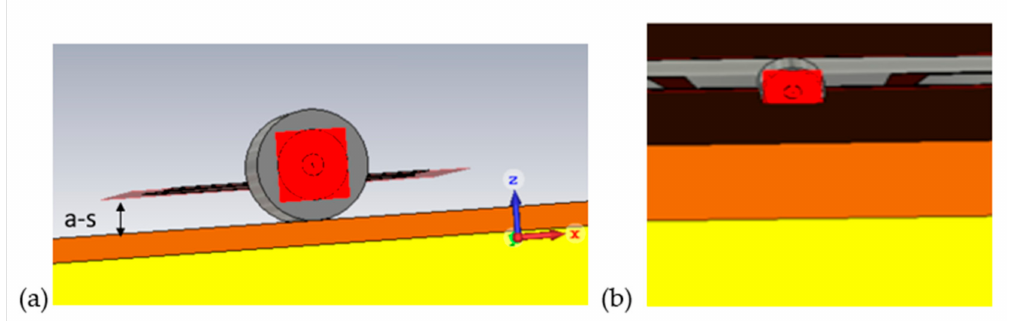
Figure 5. Dependence of the antenna-skin (a-s) distance from the cable length: ( a ) a-s = 3.2 mm as the cable thickness is 6.5 mm, ( b ) a-s = 0 mm as the antenna is on the skin layer which has been cut partially below the thin cable.